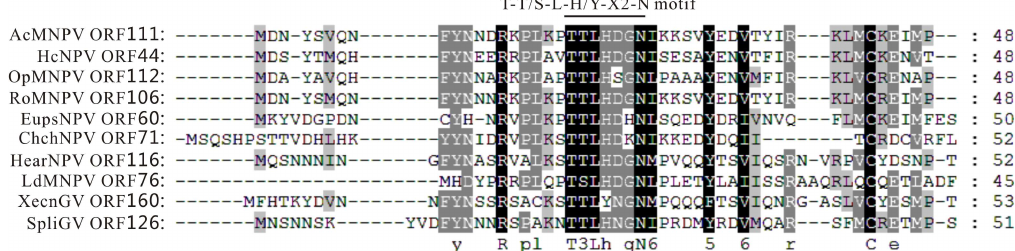
Figure 1. Multiple-sequence alignment of 10 selected Ac111 homologues. The alignment was performed and edited using Clustal X and GeneDoc, respectively. The Ac111 homologue sequences used are as follows: NP_054141.1 for AcMNPV ORF111, YP_473232.1 for HcNPV ORF44, NP_046268.1 for OpMNPV ORF112, AAN28146.1 for RoMNPV ORF106, YP_002854670.1 for EupsNPV ORF60, YP_249675.1 for ChchNPV ORF71, NP_203672.1 for HearNPV ORF116, NP_047713.1 for LdMNPV ORF76, NP_059308.1 for XecnGV ORF160, and YP_001257077.1 for SpliGV ORF126. Black, dark gray, or light gray shading denote 100%, 80%, or 60% conservation, respectively. The predicted T-T/S-L-H/Y-X 2 -N motif found in all of the homologues is indicated.